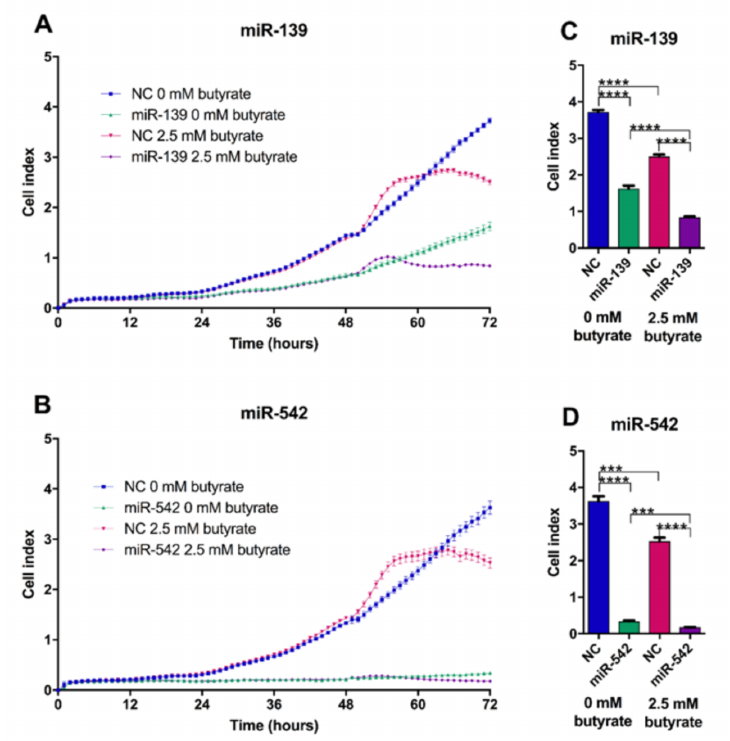
Figure 7. Proliferation of HCT116 cells after transfection with miRNA mimics and butyrate treatment for 24 h. Real-time cell index measurements using the xCELLigence RTCA platform, in HCT116 cells transfected with miRNAs ( A ) miR-139, ( B ) miR-542 for 48 h, followed by 24 h of treatment with 0 mM or 2.5 mM butyrate, over a 72 h post-transfection period. The mean ± SEM ( n = 4) is shown at 72 h post-transfection ( C ) miR-139, ( D ) miR-542. Significant results are indicated by *** p <0.001, **** p < 0.0001. NC = negative control